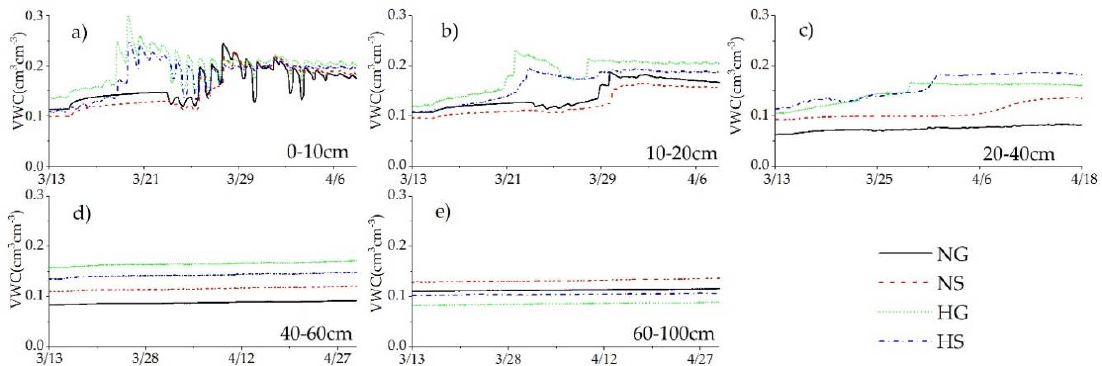
Figure 4. The variation of soil volumetric water content (VWC) at soil depths of 0–10 cm after rainfalls. ( a ) 16 mm, 2.6 mm, 6.3 mm; ( b ) 9 mm; ( c ) 12 mm; ( d ) 11.2 mm; ( e ) 7.8 mm, 5 mm; ( f ) 10.8 mm. The field capacity and wilting point refer to Yu et al. [44].